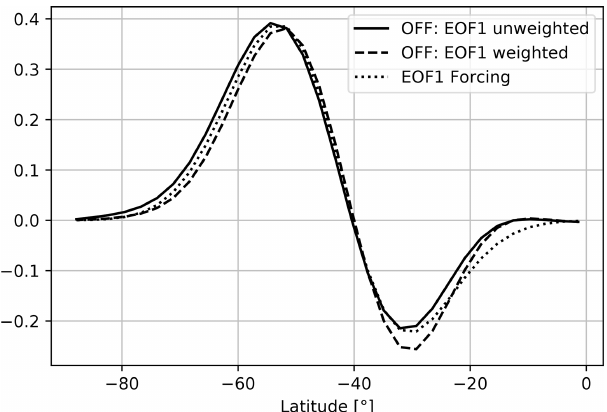
Figure 1. The EOF of zonally averaged zonal wind of the barotropic OFF experiment, both with and without using a ing. Additionally shown is the torque forcing of Eq. (5), which aims at approximating the first unweighted EOF. All curves are nor- malised by their Euclidean